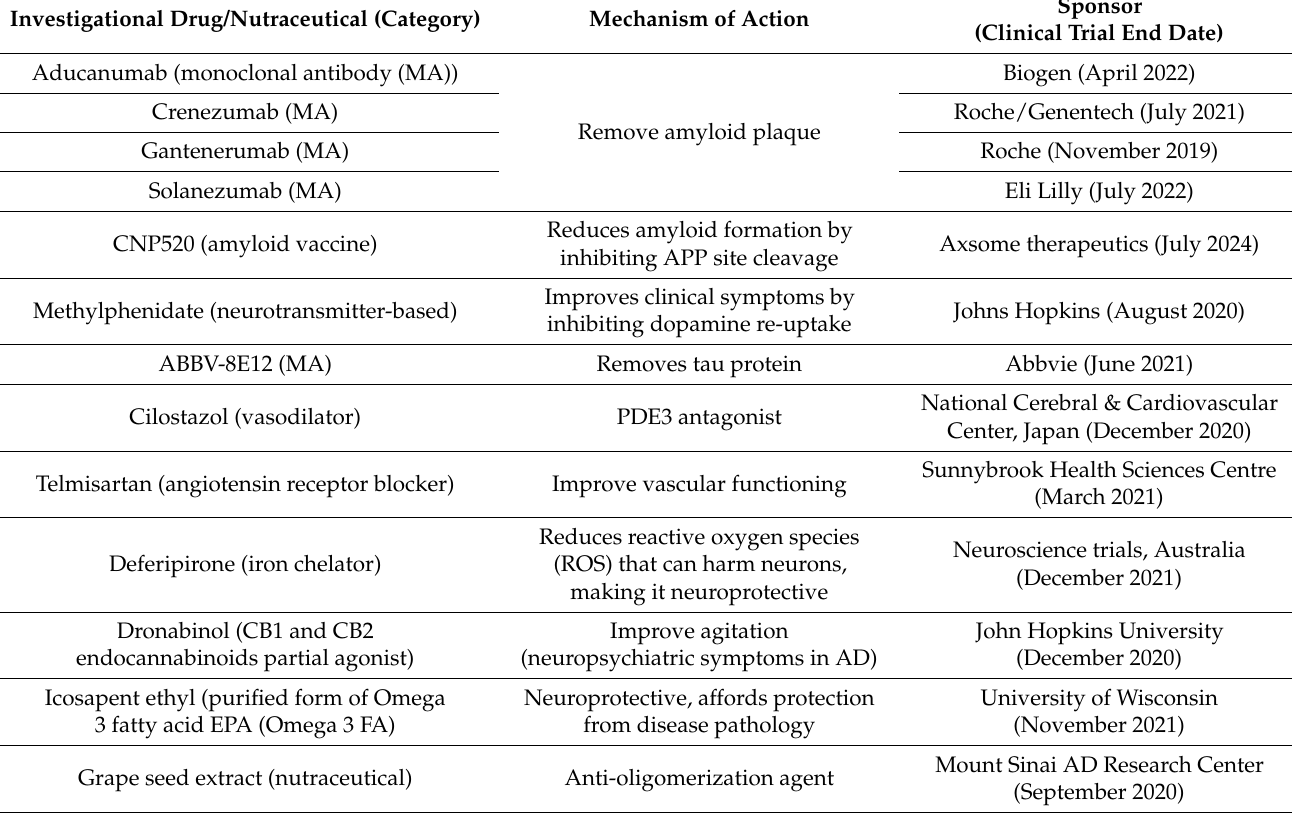
Table 1. Some of the current clinical